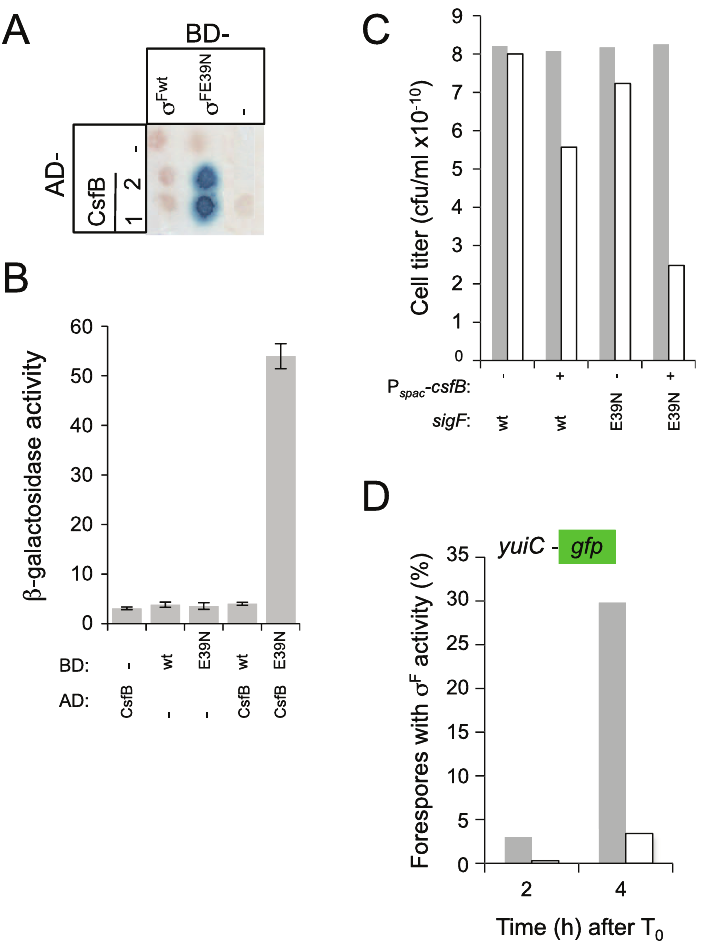
Figure 6. Interactions of CsfB with s F and s FE39N . Panels A and B show the results of a colony lift (A) or a quantitative assay on liquid medium (B) for the detection of lacZ transcription in yeast strains expressing fusions of CsfB to the activation domain (AD; two colonies are shown) and fusions of s F or s FE39N to the binding domain (BD) of GAL4. Negative controls (‘‘ 2 ’’) included BD and AD expressed from empty vectors. b -galactosidase activity was detected as described in the legend for Figure 4. The results in B are the average of three independent experiments. Panel C shows the efficiency of sporulation of strains bearing a wild type copy of the sigF operon, or a copy with the sigFE39N allele, at amyE . In addition, the strains carry the csfB gene inserted at the thrC locus under the control of the IPTG inducible P spac promoter (Table S1). The two strains (P spac - csfB spoIIAABC wt and P spac - csfB spoIIAABCE39N ; NB: the third cistron of the spoIIA operon, also called sigF , codes for s F ) were grown in DSM in the presence ( + ) or in the absence ( 2 ) of IPTG and the titer of heat resistant spores measured 18 hours after the onset of stationary phase (gray bars, viable cells; white bars, heat resistant cells). Panel D, shows the quantitative analysis of GFP expression in strains similar to those described for panel C, except that they additionally carry a fusion of the s F -controlled yuiC promoter to gfp . The two strains (P spac - csfB sigF wt P yuiC -gfp , gray bars; P spac - csfB sigFE39N P yuiC -gfp , white bars) were grown in sporulation medium (DSM) in the presence of IPTG and samples taken at the indicated times (in hours) after the onset of stationary phase for scoring the number of cells showing GFP expression by fluorescence